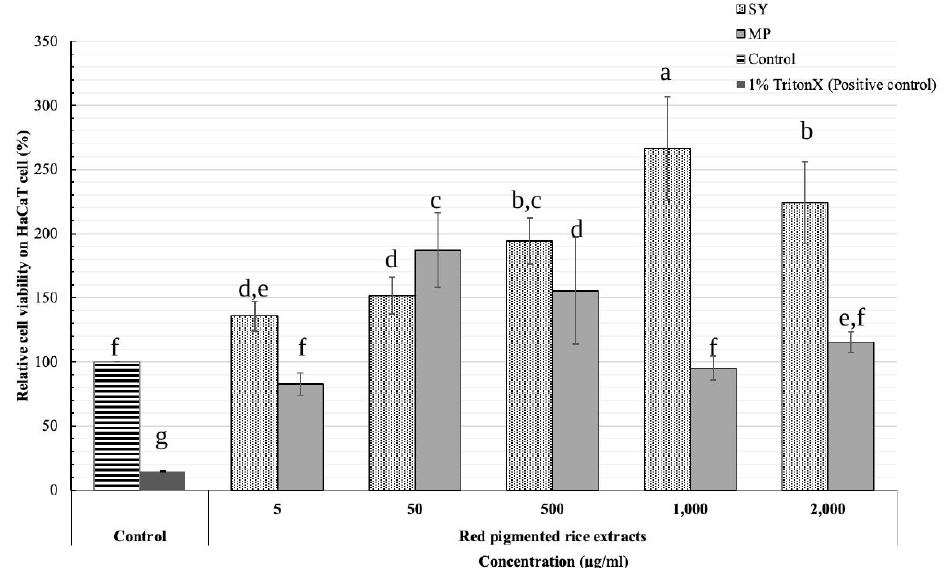
Figure 2. Relative cell viability of HaCaT cells exposed to red pigmented rice extract (SY and MP) at various concentrations (5–2000 µg/mL). Control: DI water and 1% Triton X. Different letters (a, b, c, d, e, f, g) in the graph indicate statistically different values (ANOVA, Duncan’s multiple range tests, p < 0.05).